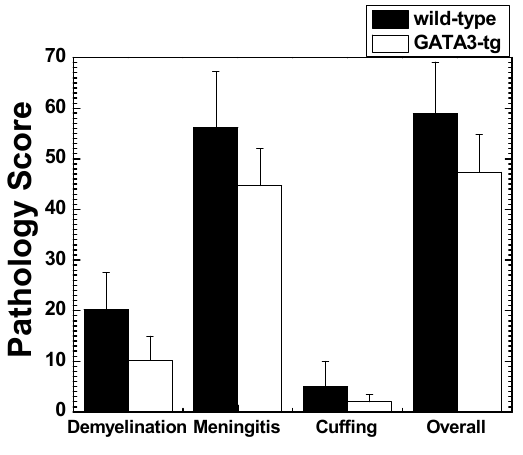
Figure 2. Spinal cord pathology of wild-type and GATA3-tg mice during the late stage of EAE. GATA3-tg mice (open column) had decreased pathology scores in meningitis, demyelination, and overall pathology, compared with wild-type mice (closed column). Values are representative mean pathology score + SEM of 10 wild-type and 12 GATA3-tg mice from four independent